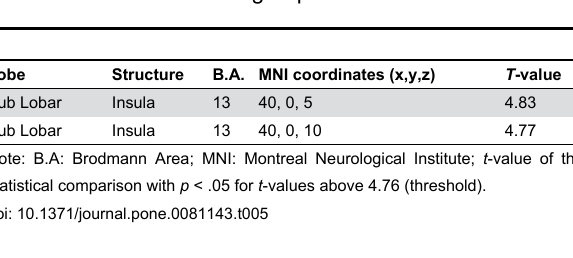
Table 5. Areas of statistically higher localized brain activation for the numerical task compared with the classical task for the HMA group.